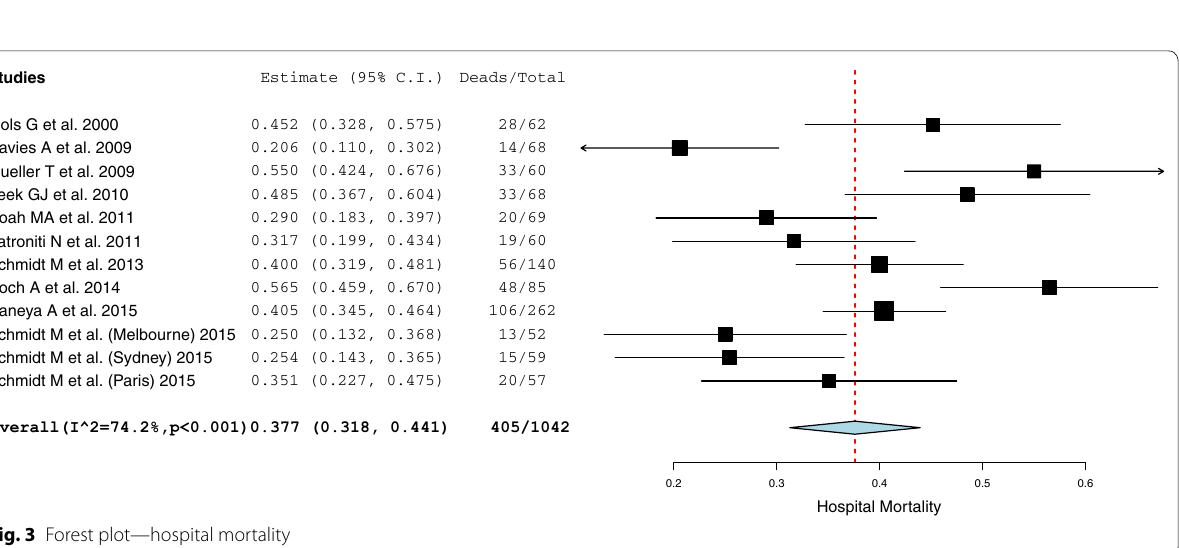
Fig. 3 Forest plot—hospital